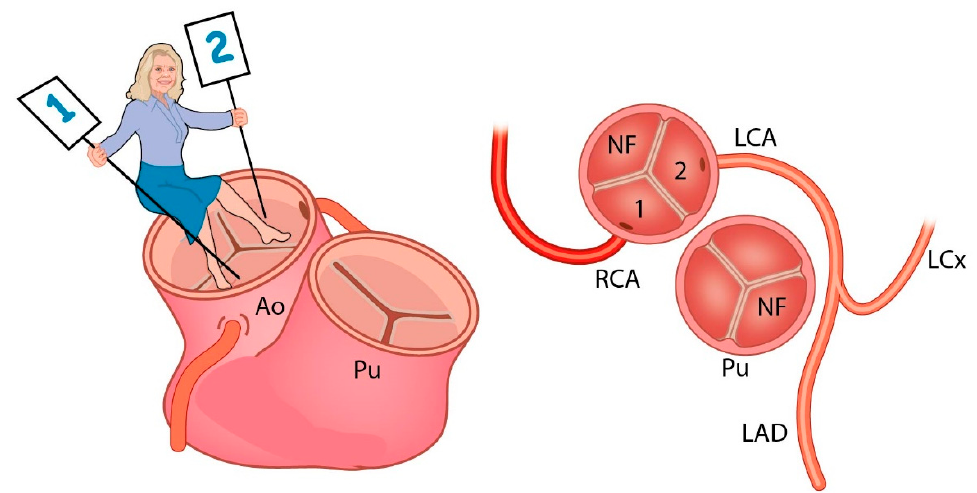
Figure 1. Ao: aorta, Pu: Pulmonary artery, NF: Non Facing sinus, RCA: Right Coronary Artery, LCA: Left Coronary Artery, LAD: Left Anterior Descending artery, LCx: Left Circumflex artery. The observer sits in the non-facing sinus of the aorta and looks towards the facing sinuses. Sinus 1 is on her right-hand side, while sinus 2 is on her left-hand side. The coronary arteries are described in a counterclockwise fashion: 1RCA-2LAD LCx. (Adapted with permission from: Gittenberger de Groot et al. J Thorac Cardiovasc Surg. 2018 Dec;156(6):2260–2269 ).